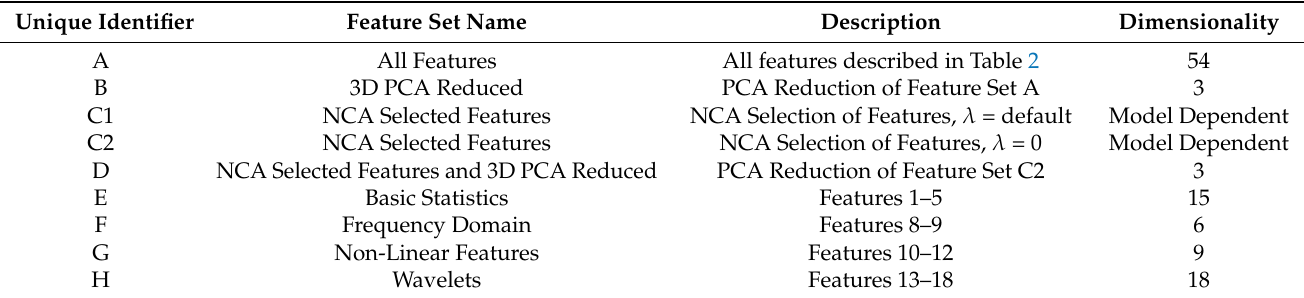
Table 3. List of feature set identifiers and names, with a description of each and the dimensionality of each feature set.